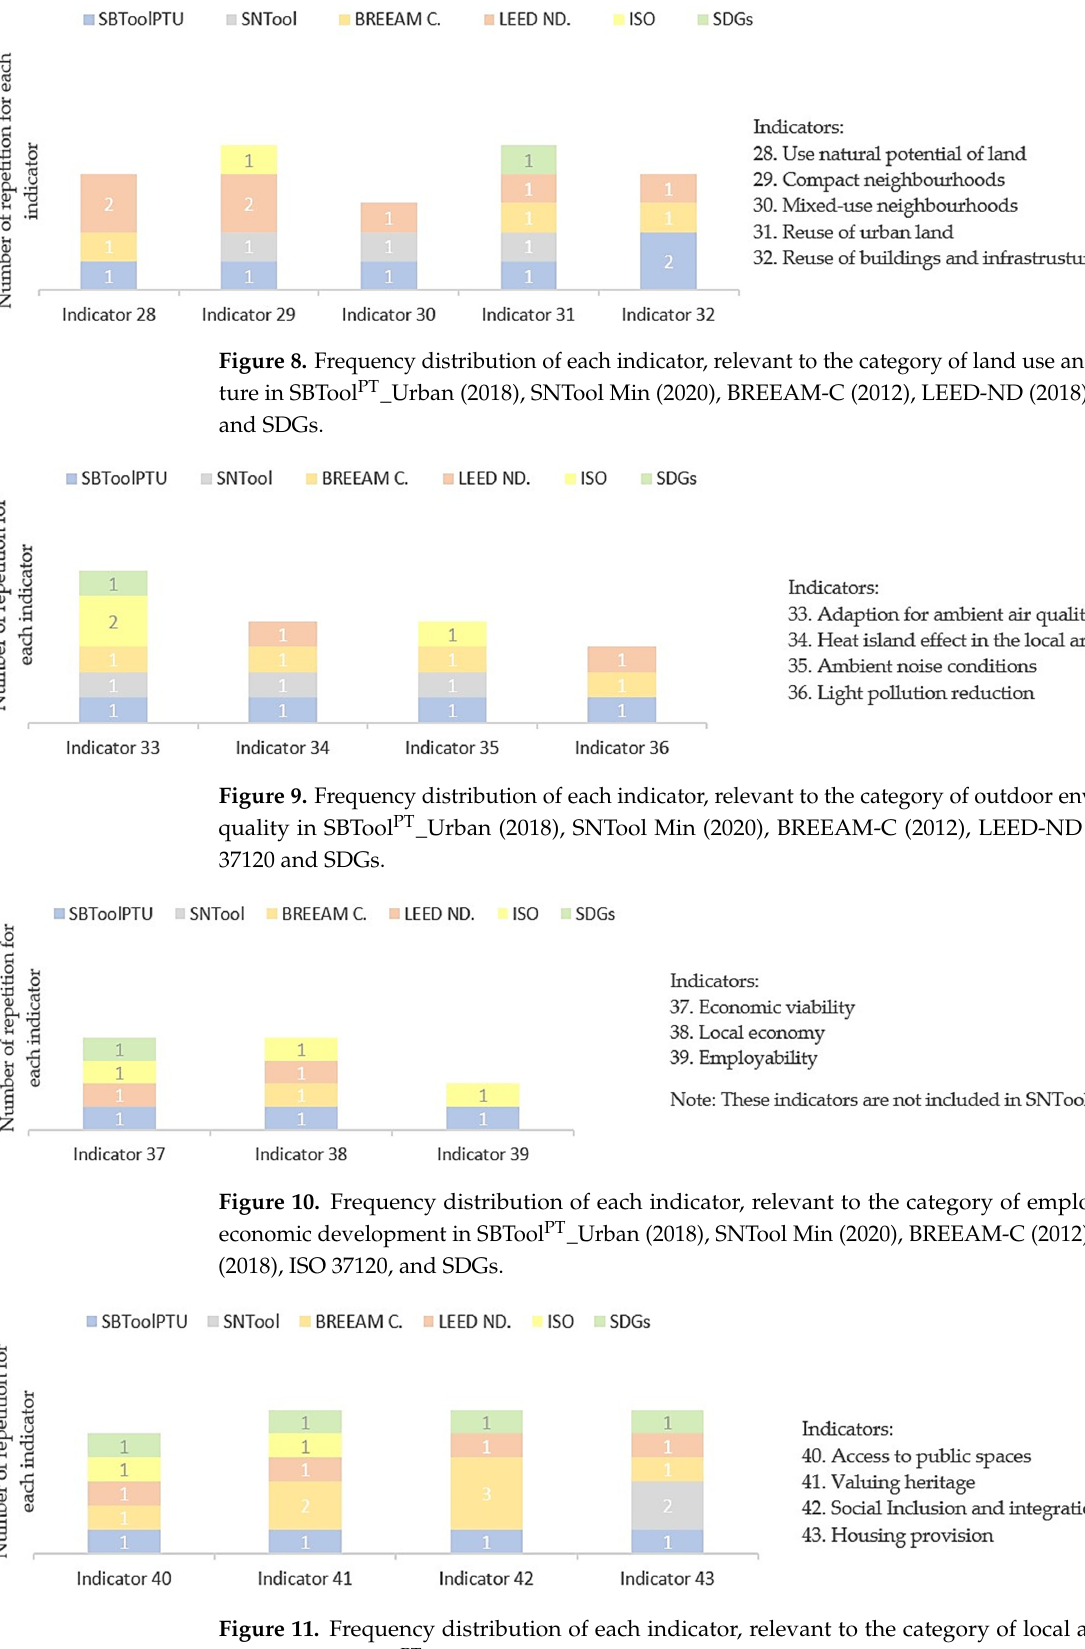
Figure 12. Frequency distribution of each indicator, relevant to the category of context and vulner- abilities in SBTool PT _Urban (2018), SNTool Min (2020), BREEAM-C (2012), LEED-ND (2018), ISO 37120, and SDGs.